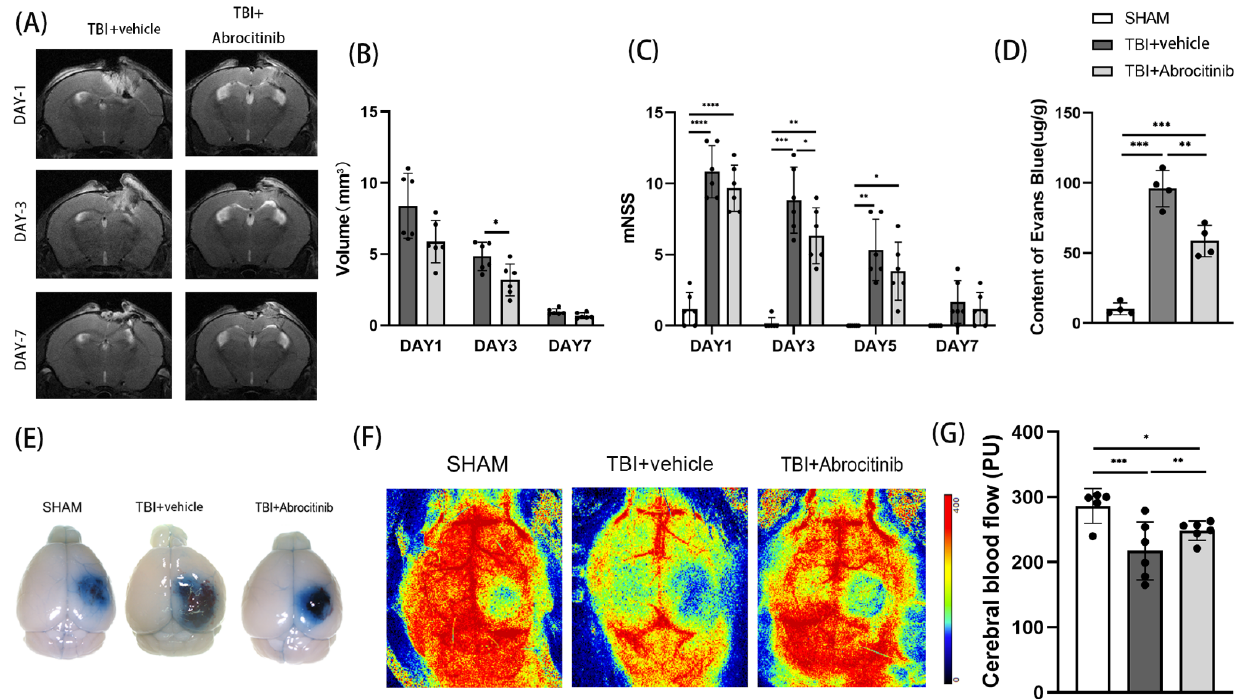
Figure 2. Effects of abrocitinib on hematoma absorption, the results of behavioral tests, cerebral edema, and cerebral cortical blood flow. Changes in trauma focus were dynamically observed with the help of MRI ( A , B ) (n = 6, repeated measures ANOVA with Tukey’s post-hoc test). In addition, neural function was evaluated using mNSS scores ( C ) (n = 6, repeated measures ANOVA with Tukey’s post-hoc test). FPI-induced vascular leakage was measured via Evans blue dye extravasation ( D , E ) (n = 4, Kruskal-Wallis test) and cerebral cortical blood flow ( F , G ) (n = 5–6, one-way ANOVA with Tukey’s post-hoc test) was also monitored on the 1st day after TBI. All data are shown as mean ± SD. * p < 0.05, ** p < 0.01, *** p < 0.001, **** p < 0.0001.